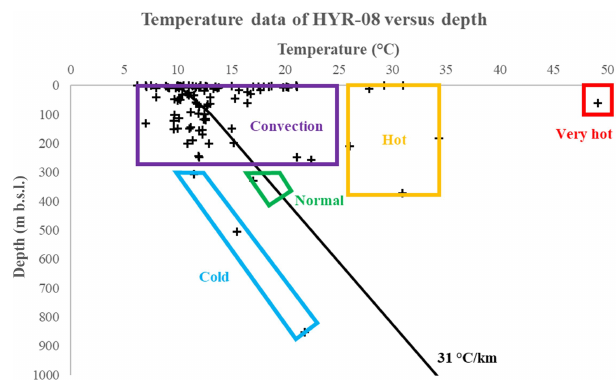
Figure 5. Temperature data of HYR-08 plotted against depth. Next to the clusters hot and very hot HYR-08 also shows the cluster cold. Only one groundwater shows a normal temperature in accordance with the typical Hessian geothermal gradient. Note that the field convection has been constrained rather arbitrarily and is not based on firm scientific